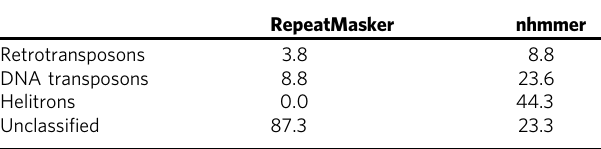
Table 2 Repetitive element composition of the